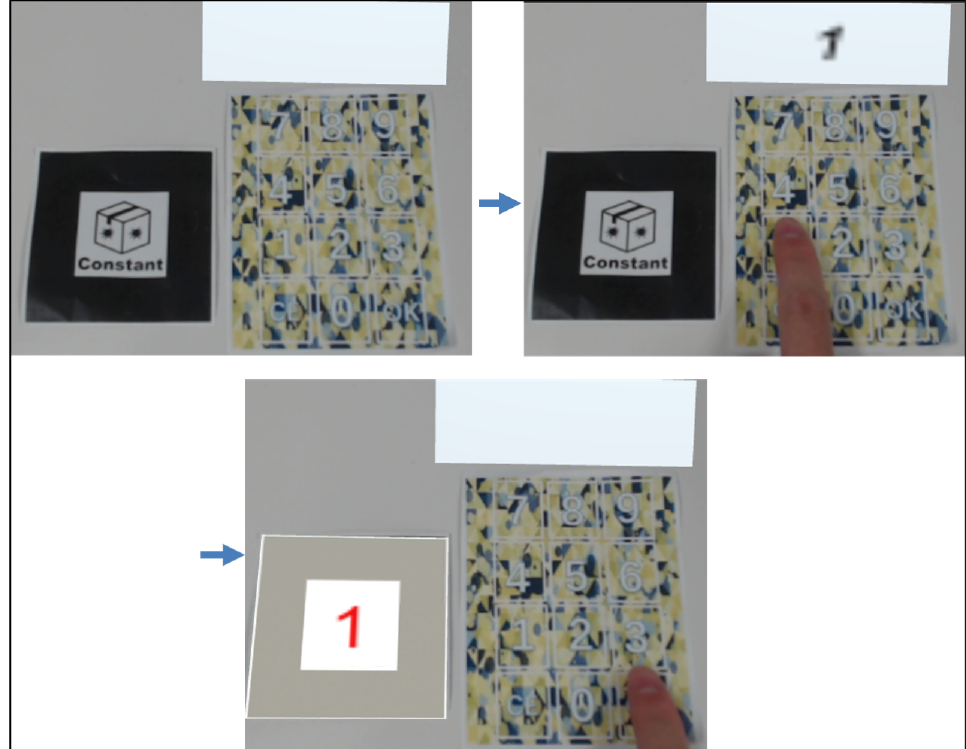
Figure 3. Figures show how to create a number virtual marker. The user first places a number template marker and a number input marker under the camera. After the system recognizes two markers, an AR display screen will be generated above the number input marker. When the user clicks on the number input marker, the input information will be displayed on the AR display screen. After the user confirms the number, a number virtual marker 1 is